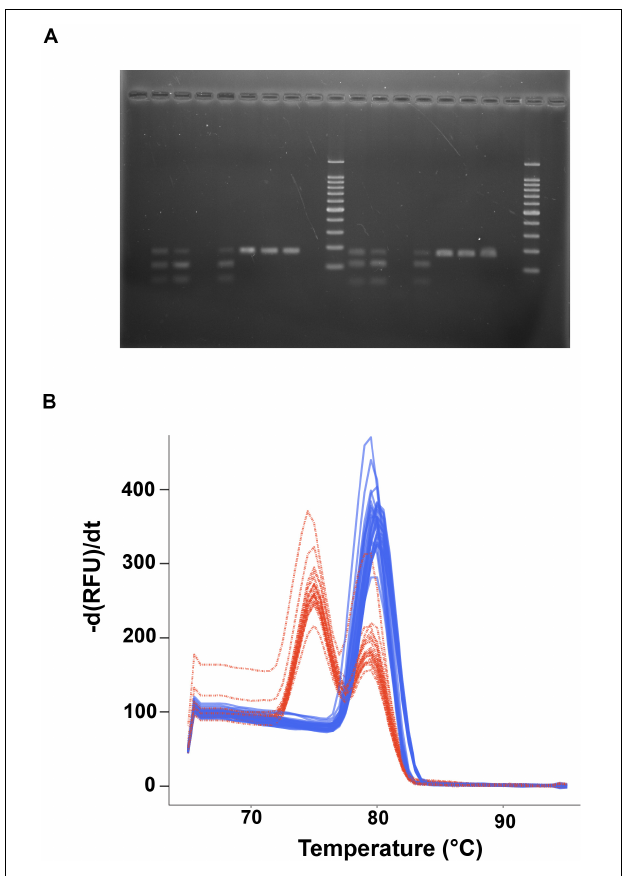
FIGURE 2 | Callinectes species identification using restriction digestion of PCR products. (A) Agarose gel image of digest results for C. sapidus samples (lanes 2,3,5, 11,12,14) and non-sapidus Callinectes crabs ( C. danea , lanes 6–8,15–17). Lane 10 is a 100 bp ladder (Promega), with markers every 100 bp from 100 to1000 bp, and at 1500 bp at the top of the ladder. (B) Plot of the negative derivative of fluorescence (relative fluorescence units, RFU) vs. temperature (-d(RFU)/dt) from a standard qPCR melt curve analysis of post-digestion 12S CSap1 PCR products. Red curves are from C. sapidus samples and show two melt peaks indicative of partial digestion of the amplicon (melt peaks at 80 ◦ C for the uncut amplicon, 74 ◦ C for the digested fragments), blue curves are from non-sapidus species and show a single melt peak from uncut, single amplicons (at 80 ◦